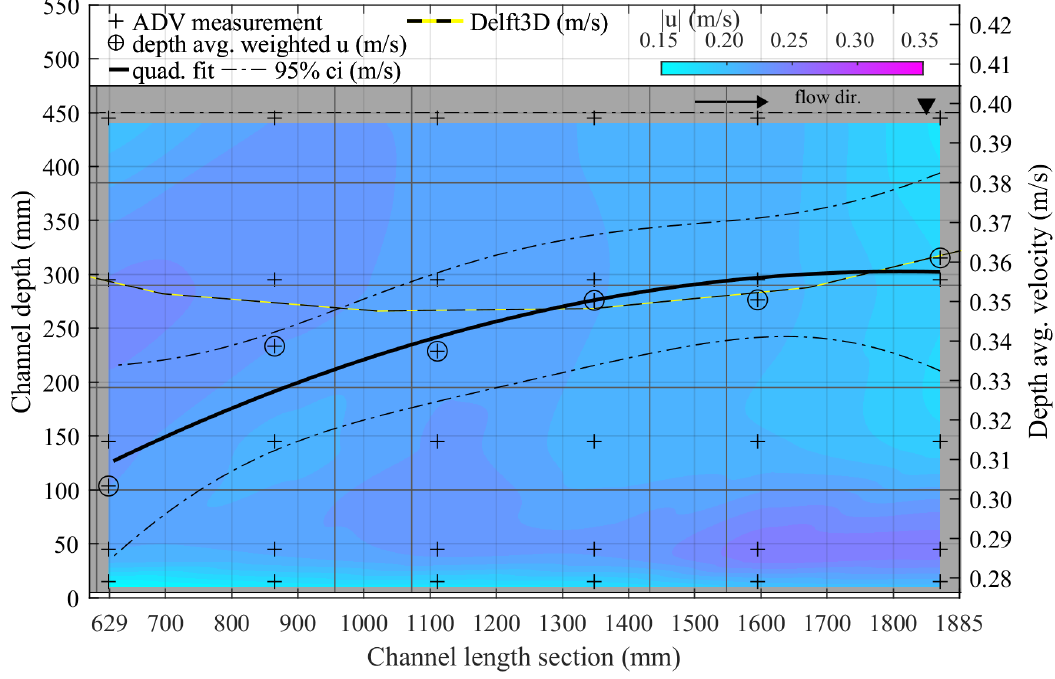
Figure 7. Velocity profile measured on the PFM in channel direction 15cm in front of the structure complimented by depth averaged values and a corresponding quadratic fit and numeric